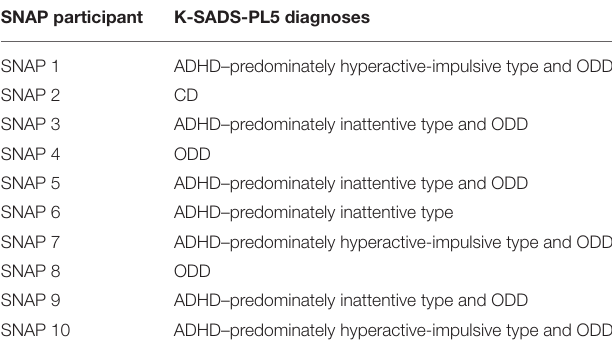
TABLE 1 | Psychiatric diagnoses among the SNAP